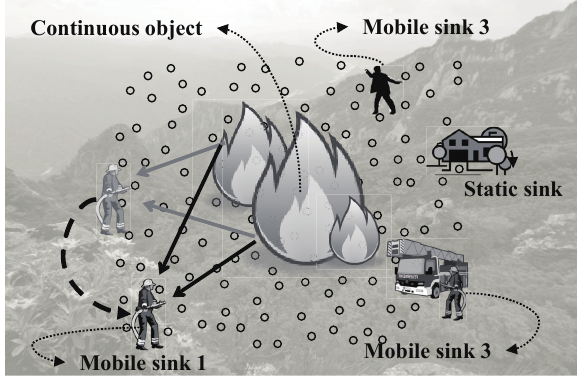
Figure 1. An example of continuous object tracking: Forest fire monitoring